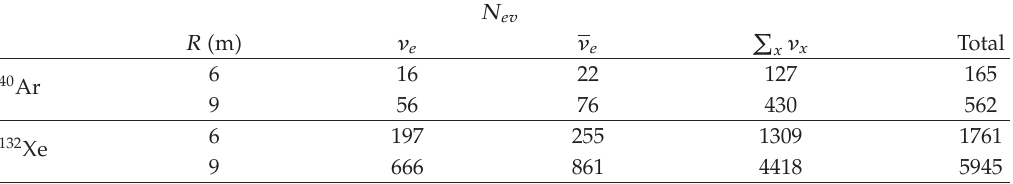
Table 7: The number of events rate for a spherical detector of various radii R . The neutrinos are emitted from a supernova at a distance L (cid:8) 10Kpc. The spherical vessel of volume V is filled with gas under pressure P (cid:8) 10Atm and temperature T 0 (cid:8) 300K. The chemical potential of the neutrino spectra is taken as α (cid:8)